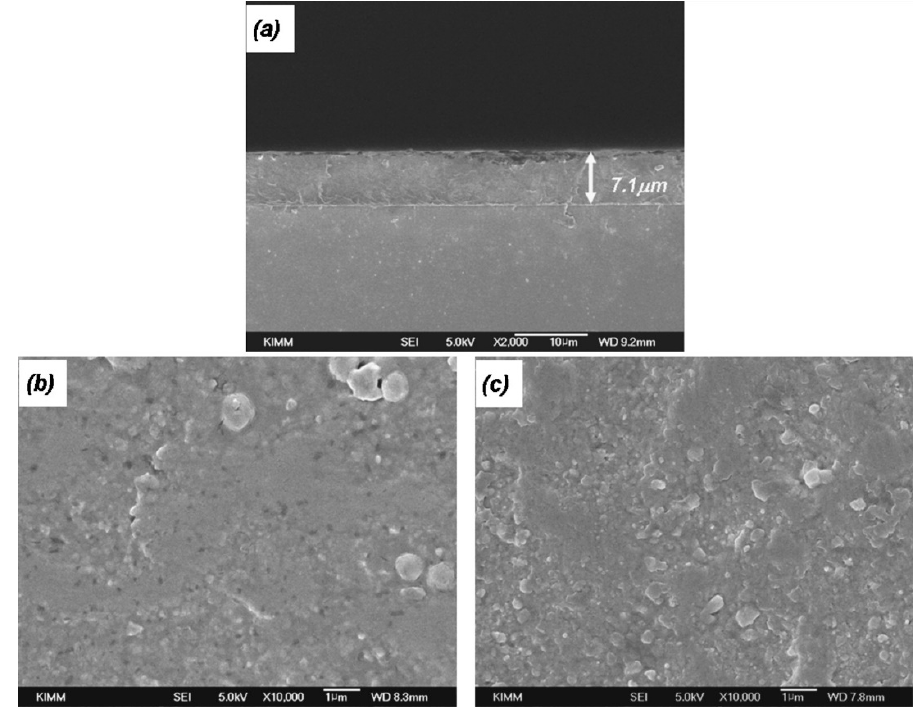
Figure 14. Scanning electron microscopy (SEM) images of the AD films ( a ) cross section, ( b ) as-deposited film, and ( c ) annealed (K,N)aNbO 3 (KNN) film [8]. © Copyright 2007, Appl. Phys. Lett.